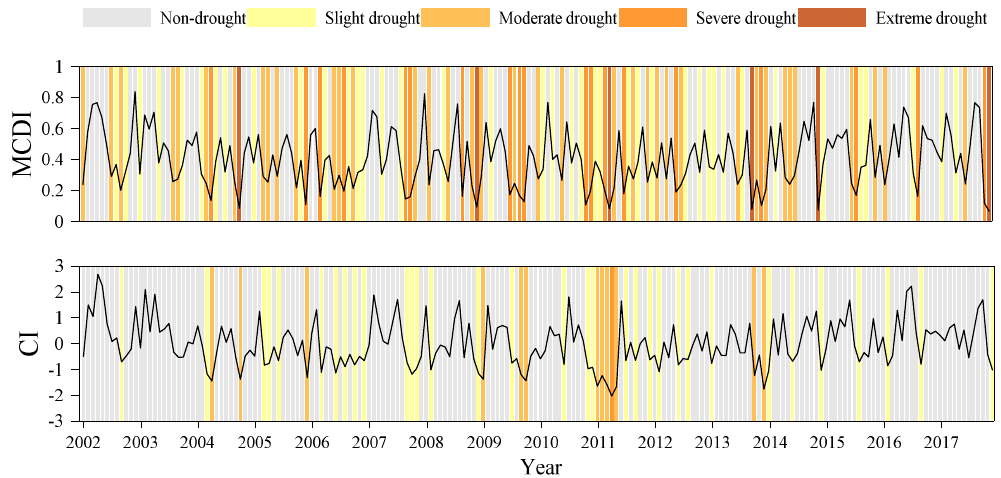
Figure 3. Monthly mean MDCI and CI values and the corresponding drought states for all stations in Hubei Province.